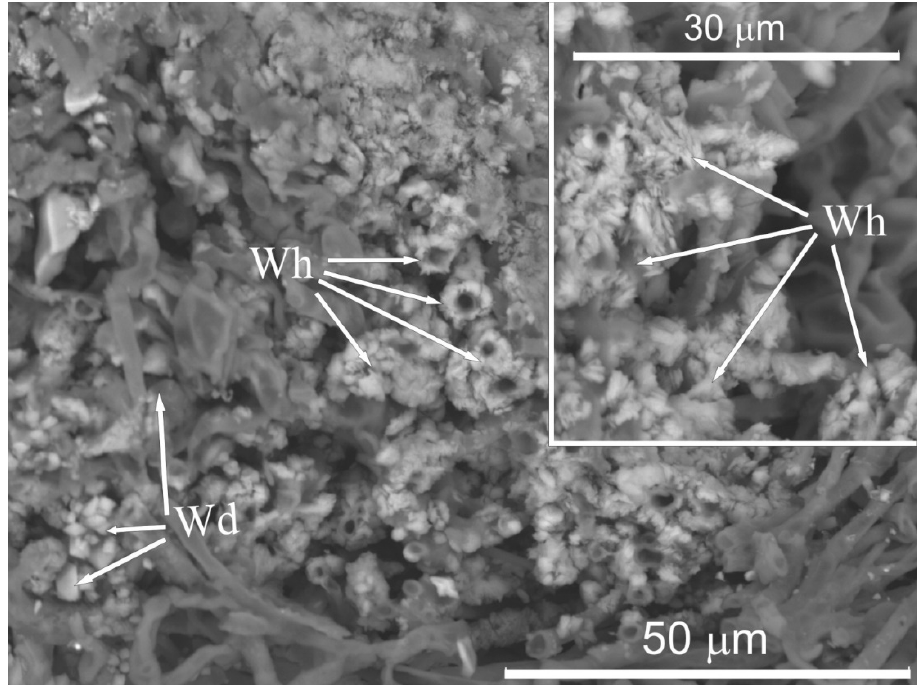
Figure 11. SEM-images of calcium oxalate crystals in lichen dominated biodeposits on the surface of homogeneous calcite marble: dipyramidal crystals of weddellite (Wd) and lamellar crystals of whewellite (Wh).